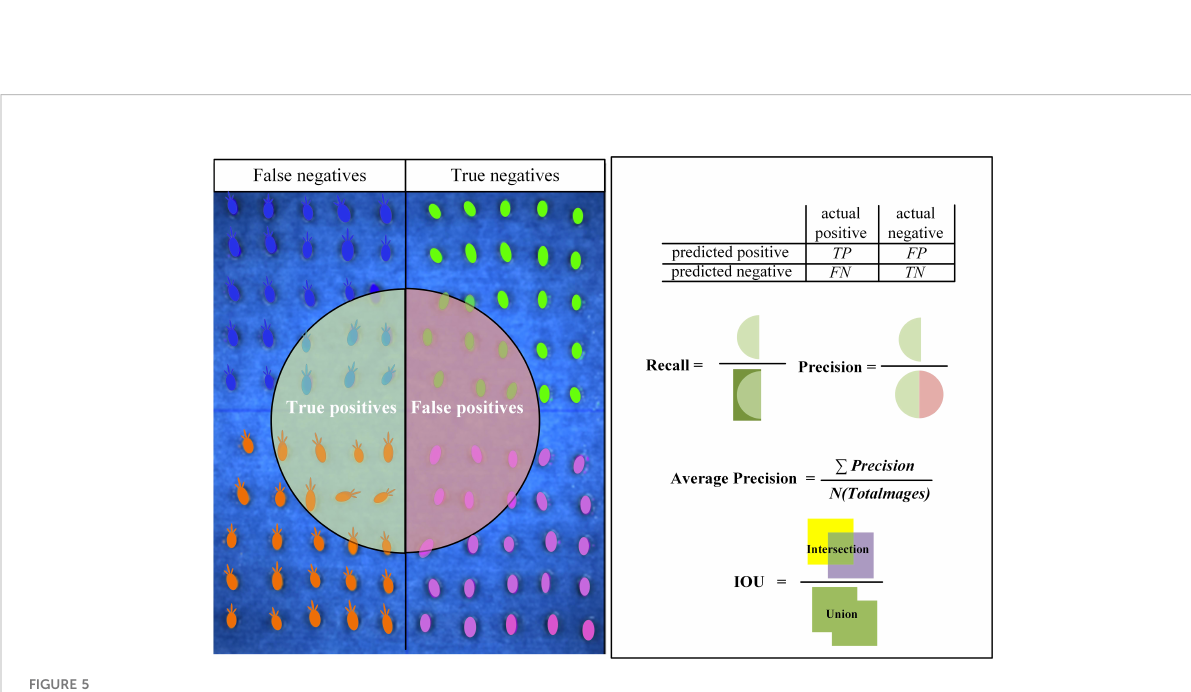
FIGURE 5 Evaluation indices of the